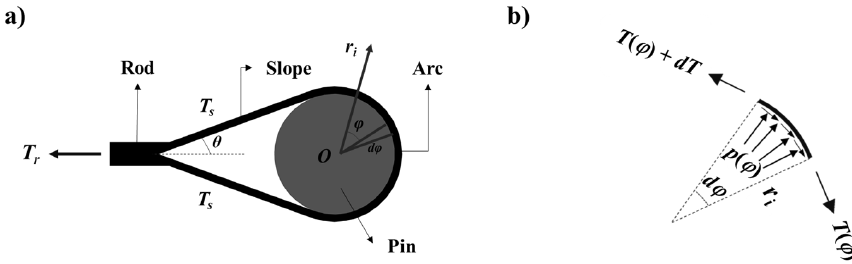
Figure 3. ( a ) Mechanical model of the U-head; ( b ) stress state of a micro-element of the arc.